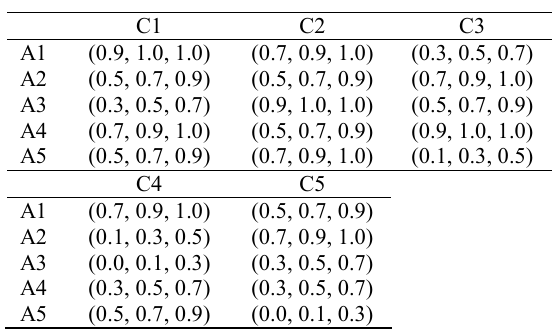
Table 3. Fuzzy preferences for the five candidate